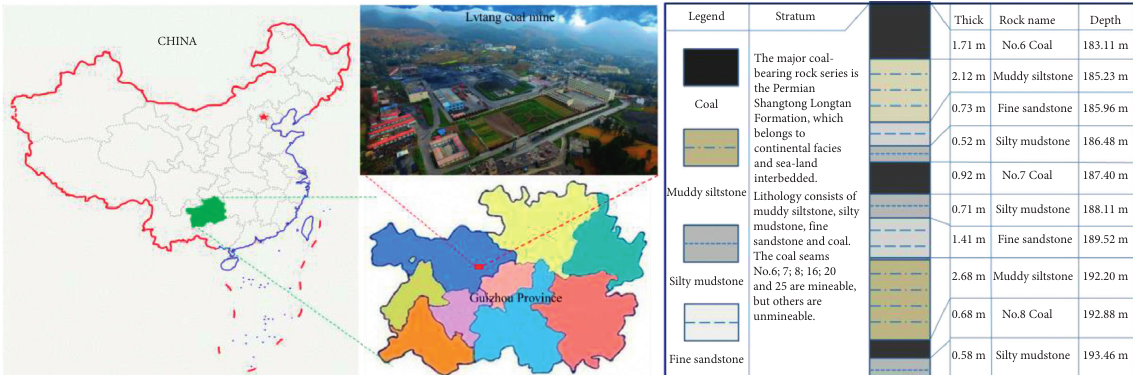
Figure 8: Geographical location of the Lvtang coal mine and the coal seam stratigraphic